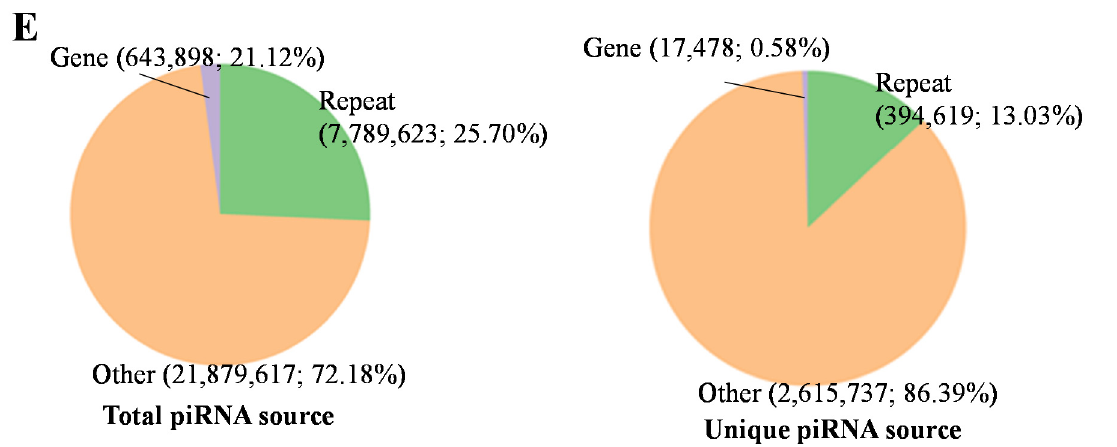
Figure 1. Characteristics of piRNAs in C. lucidus gonads. ( A ) Length distribution of piRNA sequences. ( B ) 5’-end base bias for different piRNA lengths. ( C ) Base bias at different base positions. ( D ) piRNA distribution in genomic regions (only showing the typical 10 chromosomes). The outer circles indicate chromosomal locations, and inside circles with red and green peaks indicate the piRNA distribution. ( E ) Venn diagram showing the piRNAs mapped to transposons and genes.